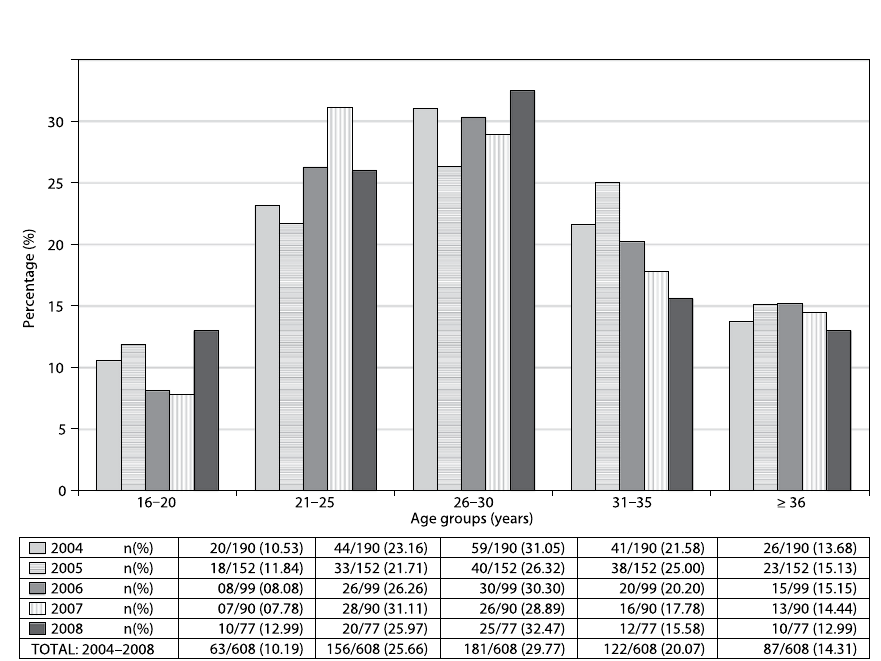
Figure 1: Trends in syphilis prevalence per total number of reactive VDRL/RPR by age group for combined clinics per year,